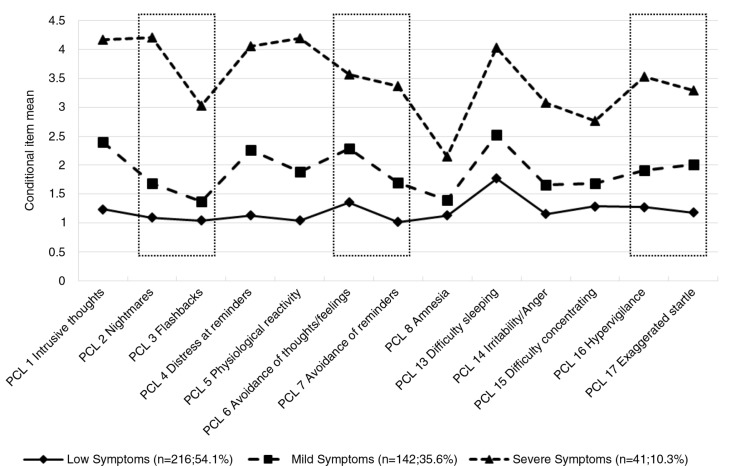
Conditional symptom severity means by cluster. Symptoms in boxes are proposed ICD-11 PTSD symptoms. PCL=Posttraumatic Stress Disorder Checklist.